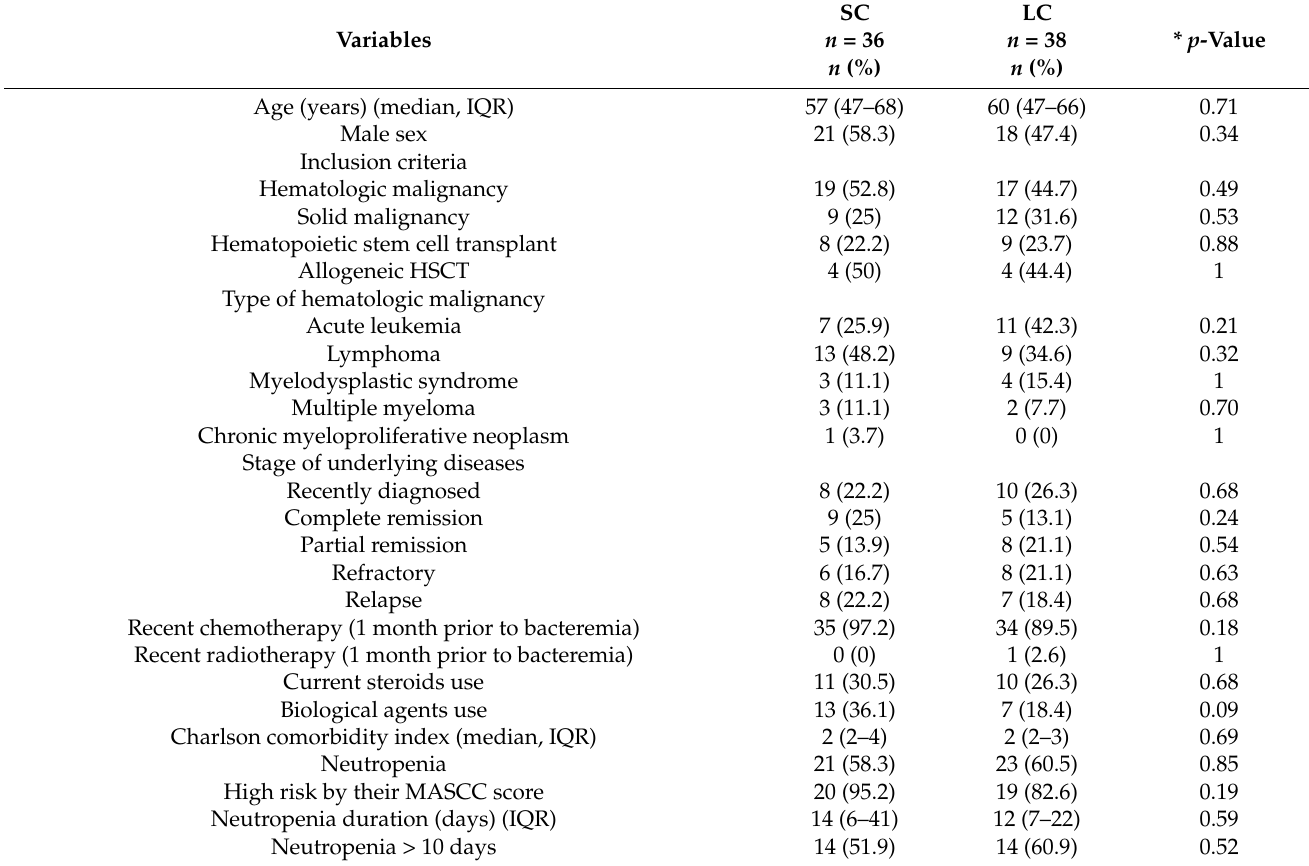
Table 1. Baseline characteristics of patients with Gram-negative bacilli